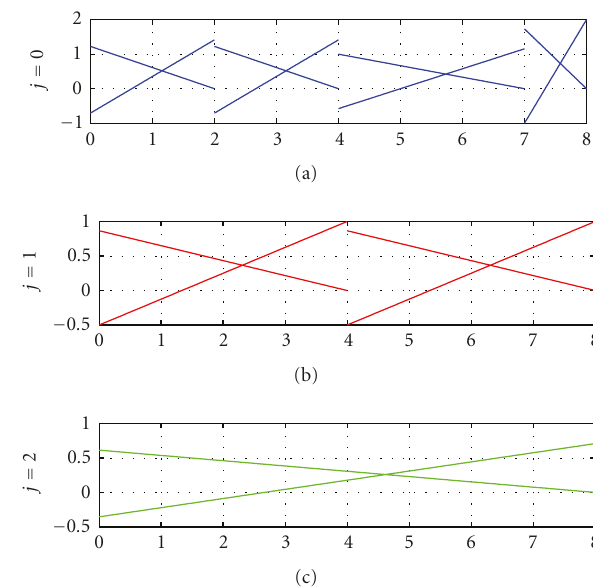
Figure 2: Haar scaling functions at resolutions j = 0,1,2. Figure 3: Linear scaling functions at resolutions j = 0,1,2.